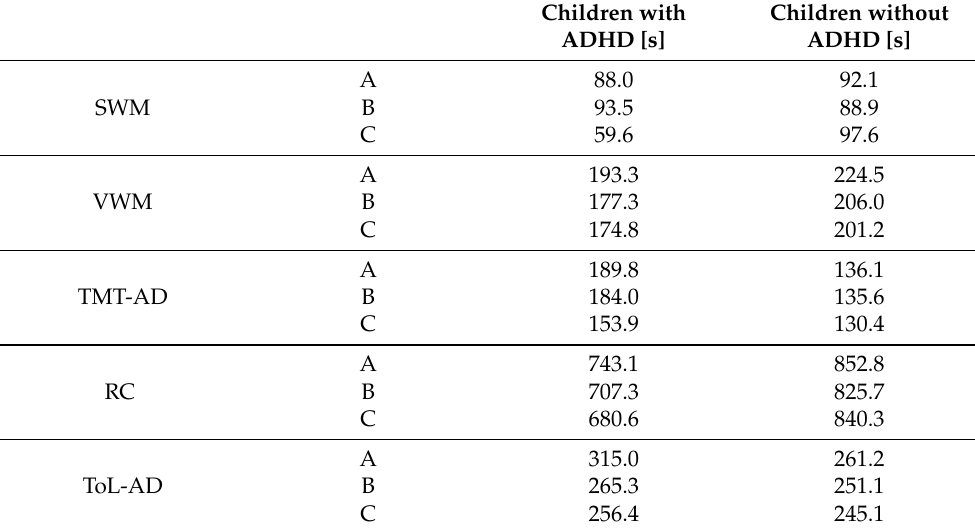
Table 3. Mean value of the task solving times for children with and without ADHD. The seats are marked as A—active seat, B—therapy ball and C—school chair.